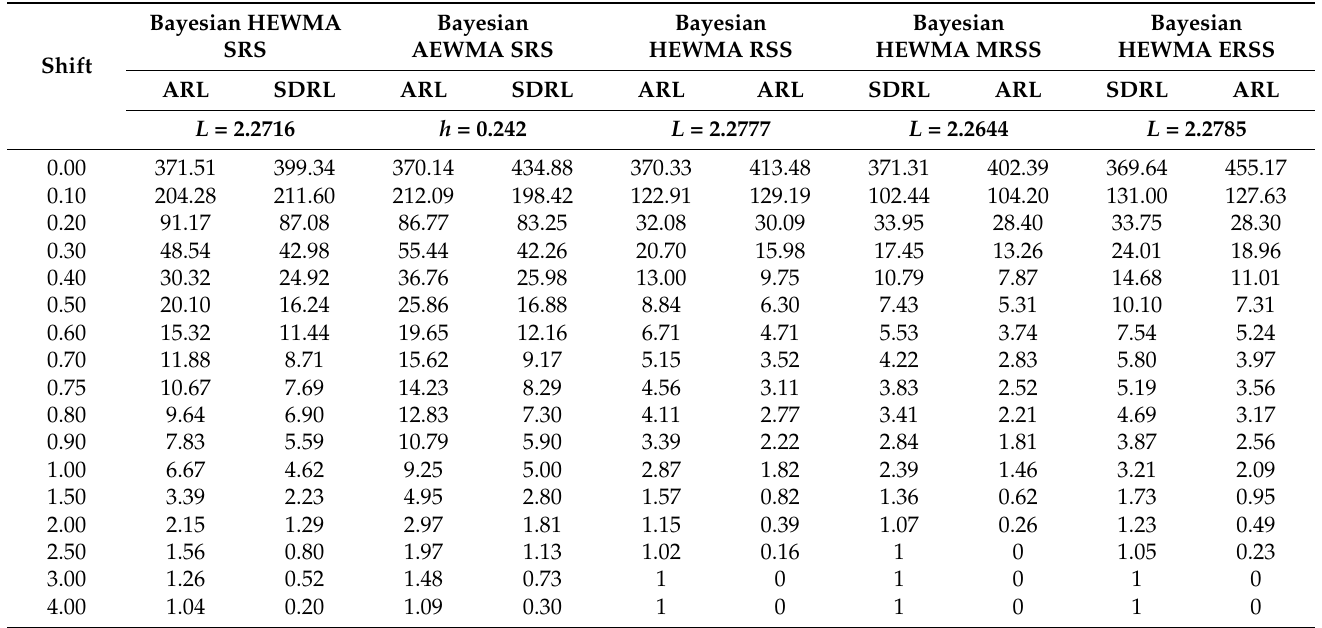
Table 4. The ARL and SDRL values of Bayesian HEWMA and Bayesian AEWMA control chart for